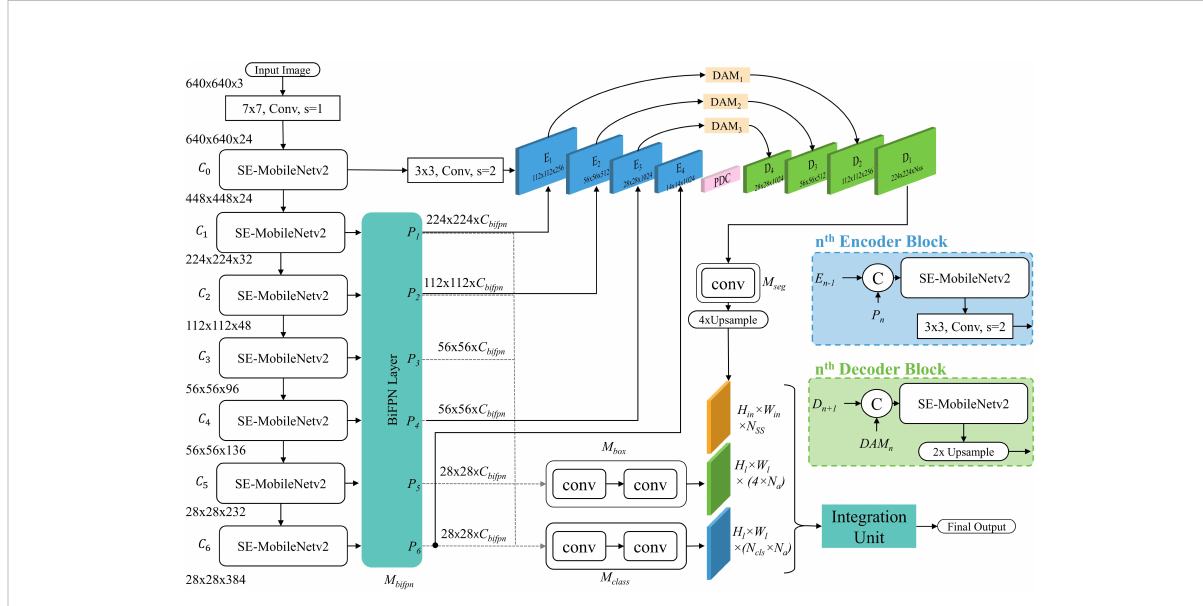
FIGURE 4 Overall architecture of the DIANA framework. The whole framework is end-to-end